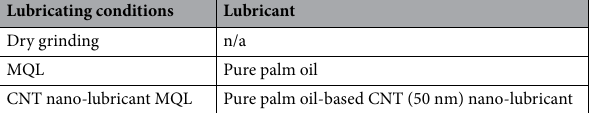
Table 5. Experimental